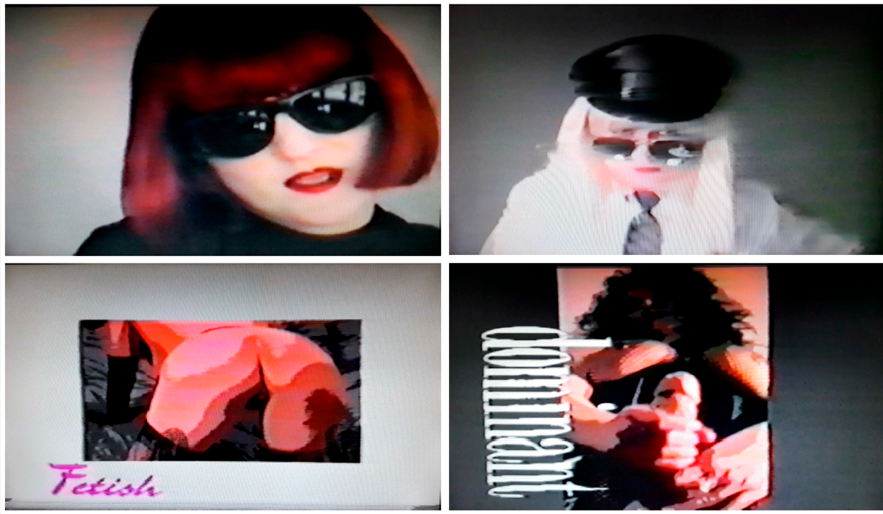
Figure 7. Master/Slave Relationship, MSR A To Z , Minus Habens Records, 1993, VHS. In 1984, the members of the Slovenian band Borghesia performed the Lustmörder show held at the Cankarjev dom in Ljubljana. A poster designed by the artist Dušan Mandi´c was shown at the back of the stage and read: “1968 is over. 1983 is over. The future is between your legs” (“ 1968 I prošla. 1983 I prošla. Budu´cnost je izme ¯du vaših noga ”), expressing the desire of the members of Borghesia and their entourage to deepen their reflection on sexuality—its practices and modes of representation—in industrialised societies (Figure 8). According to the historian David Crowley, “the poster made it clear that Borghesia and other members of Ljubljana’s subculture rejected the progressive and universalising rhetoric of sexual liberation which had been announced so boldly at the end of the 1960s. Sex in subcultural Ljubljana had to be freed not only from the petit-bourgeois morality of the League of Communists but also from the humanist libertarians” (Crowley 2015).